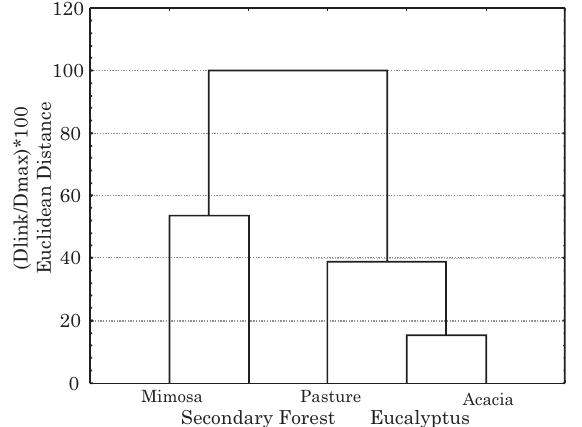
Figure 2. Dendrogram of dissimilarities of abundances and taxonomic groups of soil fauna in Acacia mangium (acacia), Mimosa artemisiana (mimosa), Eucalyptus grandis x E. urophylla (eucalyptus), pasture and secondary forest in the rainy season.